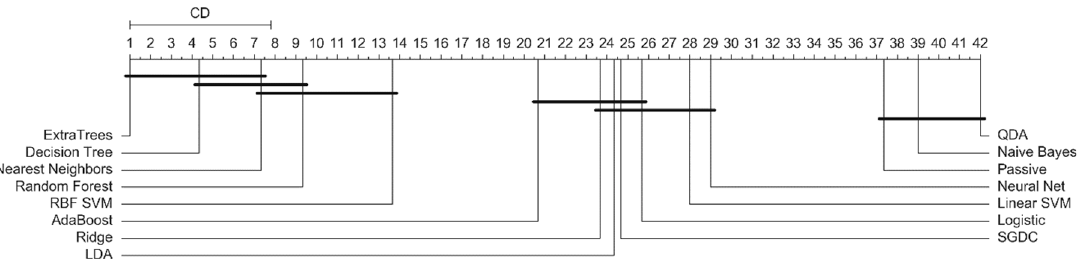
Figure 10. Comparison of mean ranks of final-stage classifiers based on their F1-score performance.